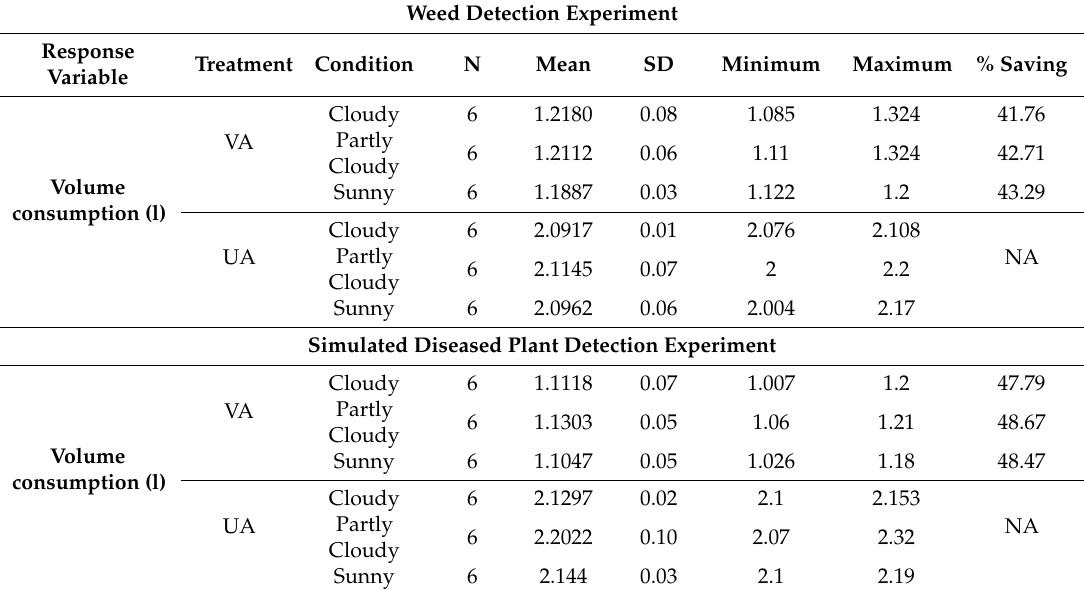
Table 5. Descriptive statistics for volume consumption of spraying liquid using two spraying techniques (treatment VA and UA) under three weather conditions (cloudy, partly cloudy, and sunny) for weed and simulated diseased plant detection experiments.